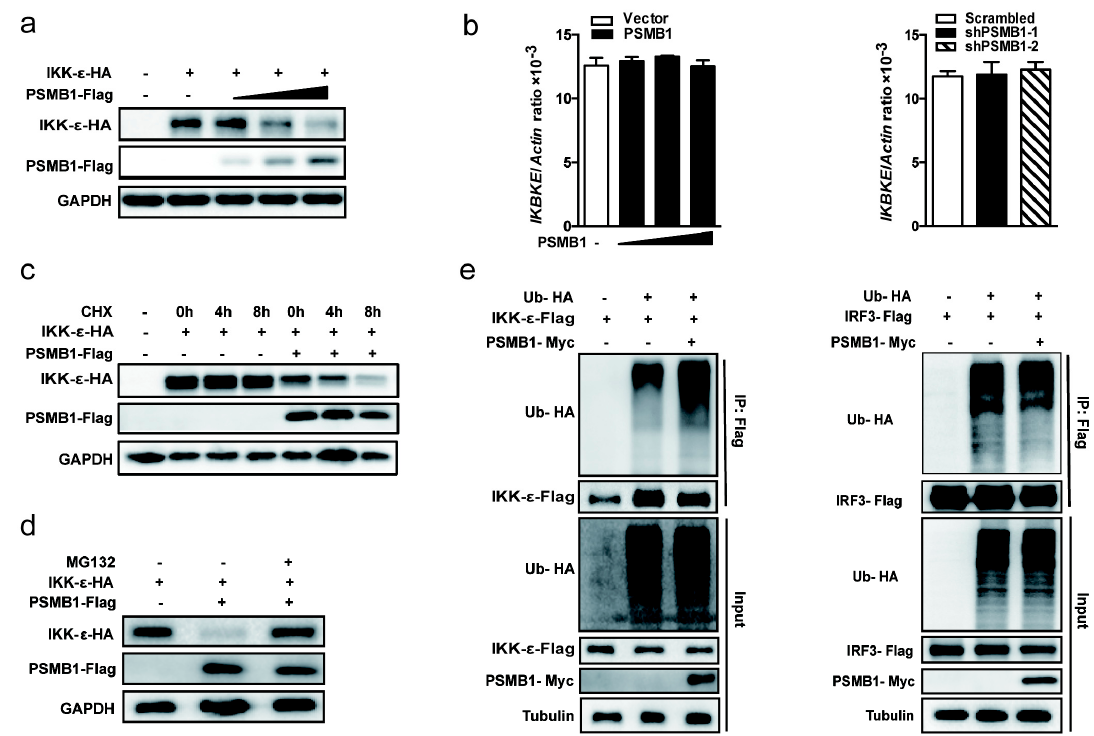
Figure 5. PSMB1 promotes IKK- ε degradation. ( a ) Quantification of IKK- ε protein level by immunoblotting from HEK293T cells expressing increasing amounts of Flag-PSMB1 together with HA-IKK- ε . ( b ) Quantification of the IKBKE mRNA level by qPCR in HEK293T cells expressing increasing amounts of PSMB1 (left panel) or PSMB1 -targeting shRNA (right panel). Data shown are the mean ± SEM. ( c ) Quantification of the IKK- ε protein level by immunoblotting from HEK293T cells transfected with the indicated plasmids and treated with 75 ng/mL of cycloheximide (CHX) for the indicated time points. ( d ) Quantification of IKK- ε protein level by immunoblotting from HEK293T cells transfected indicated plasmids and treated with 10 uM MG132 for 6 h. ( e ) HEK293T cells were co-transfected with HA-ubiquitin (HA-Ub), Myc-PSMB1, Flag-IKK- ε or Flag-IRF3. Cells were treated with 10 uM MG132 for 6 h. Anti-Flag IKK- ε or IRF3 immunoprecipitates were analyzed by immunoblotting with anti-HA antibody. Representative results are from at least three independent